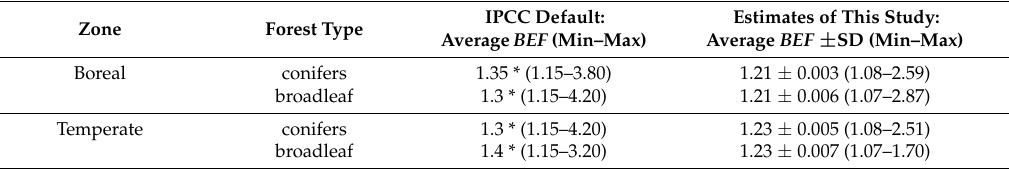
Table 2. Comparison of IPCC 2003 [12] Tier 1 default BEFs and our (GSV weighted average) estimates for